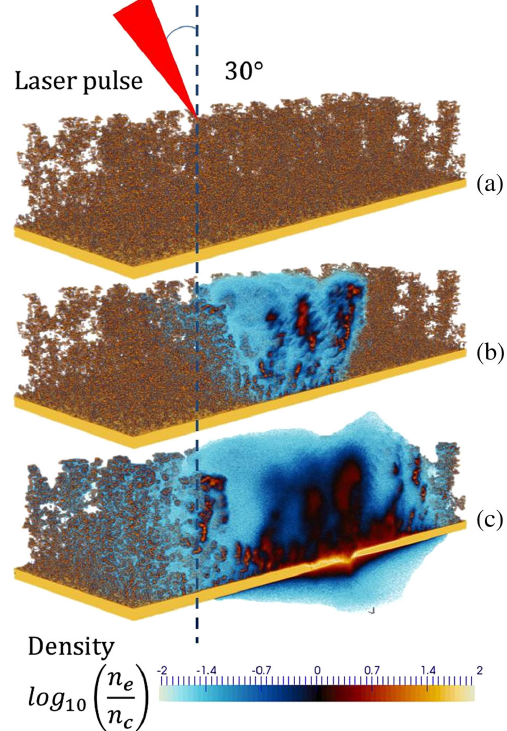
FIG. 4. 3D – PIC simulations of the electron density dynamics in the interaction between a laser pulse and a nanostructured foam at different times: (a) 0 fs, (b) 67 fs, and (c) 134 fs. The red cone represents the incident laser, and the yellow layer indicates Al substrate.